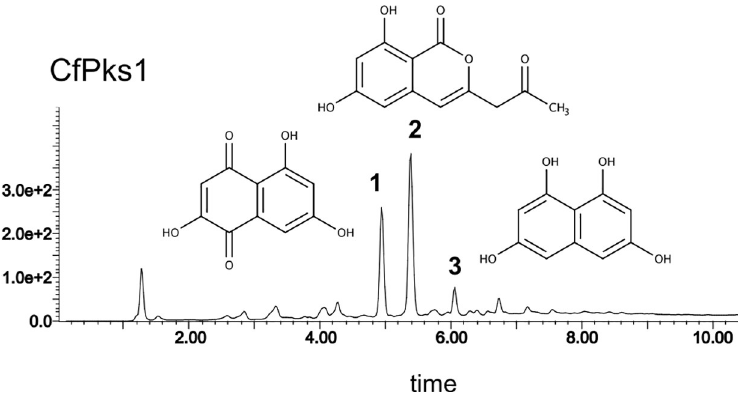
Fig 3. Heterologous expression of CfPks1 in Aspergillus oryzae . Representative diode array chromatogram of ethyl acetate extracts from transformants expressing CfPks1. These transformants produced three major compounds